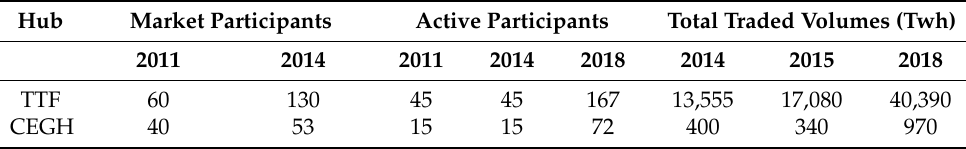
Table 1. Virtual Trading Point (VTP)